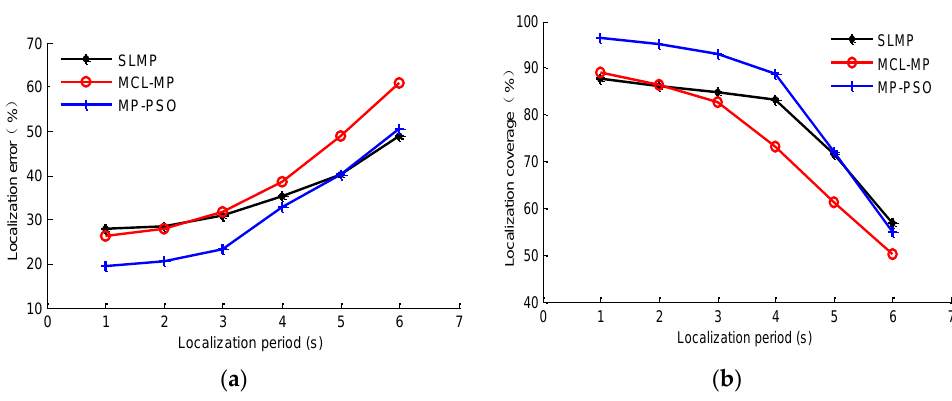
Figure 11. Impacts of localization period on localization results: ( a ) impact on localization error; ( b ) impact on localization coverage.